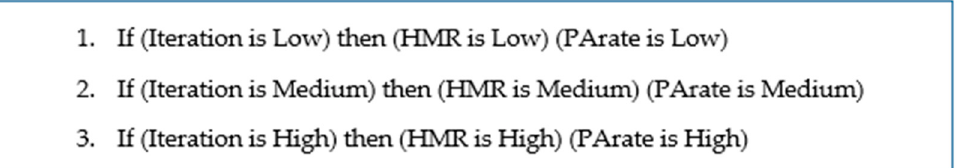
Figure 12. Rules for Fuzzy System 3 to Increase (FHS3). Algorithms 2016 , 9 , 69